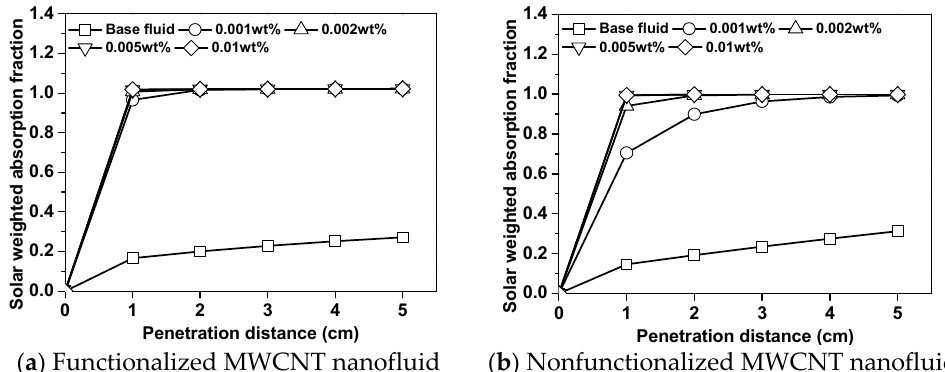
Figure 8. Solar weighted absorption fraction of ( a ) functionalized and ( b ) nonfunctionalized MWCNT nanofluid.